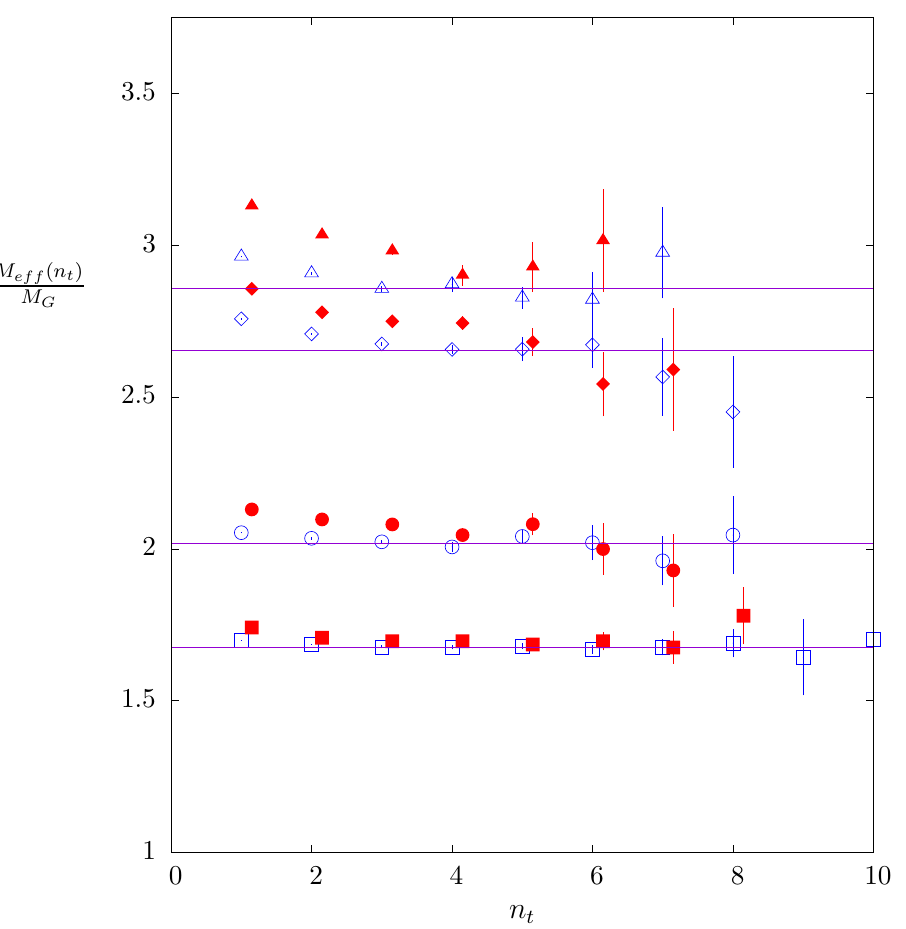
Figure 29 . Some glueball e(cid:11)ective masses in SU(4) (open points) and SO(6) ((cid:12)lled points), in units of their respective mass gaps, and at our smallest value of a : lightest 2 + , (cid:3) , (cid:12)rst excited 2 + , (cid:14) , lightest 0 (cid:0) , (cid:6) , and lightest 1 + , M . The 1 + and 0 (cid:0) have been shifted up by +0 : 5 for clarity. It is worthwhile to see if our results also demand that g 2 N should be kept